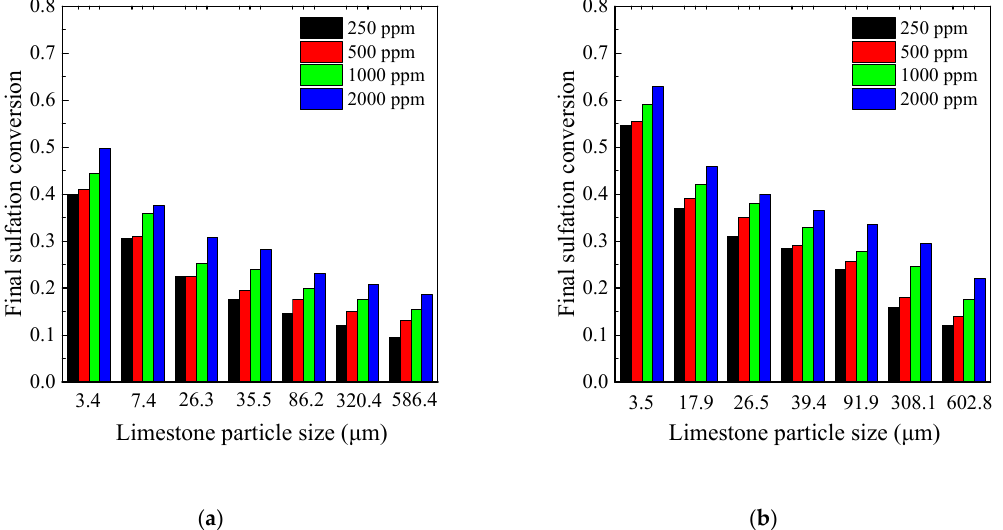
Figure 10. The final sulfation conversion at different SO 2 concentrations under 850 ° C: ( a ) Samcheok; ( b ) Shengzhou.